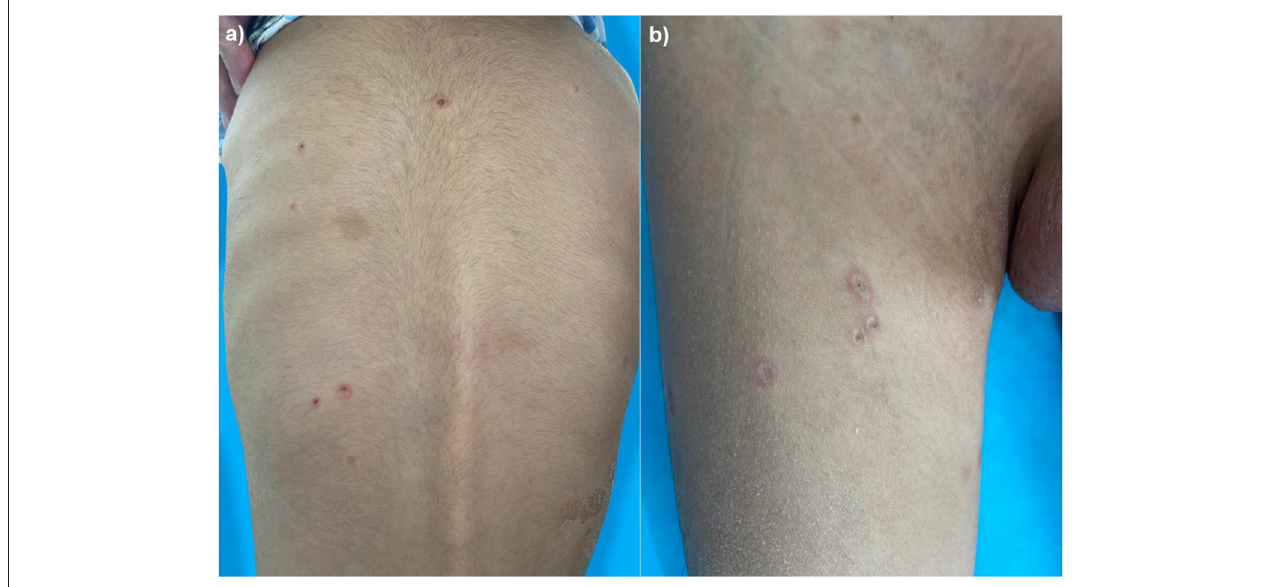
FIGURE 1 | Scarring papules with central ivory depression and rims of erythema on the trunk (a) and lower extremities (b) .